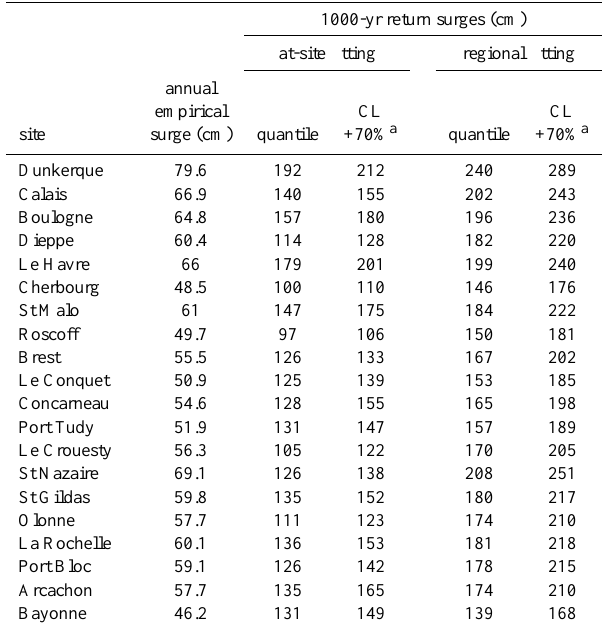
Table 3. Annual empirical surges and 1000-yr return surges at each site for at-site fitting or regional frequency